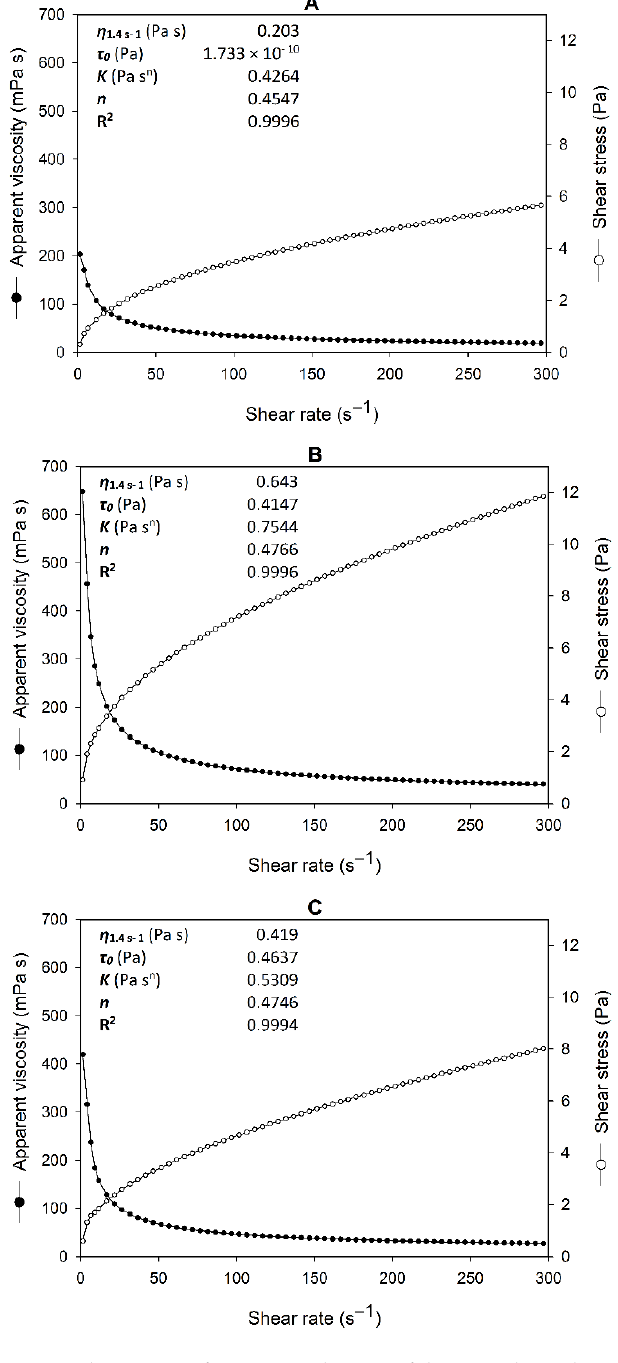
Figure 4. Rheograms of aqueous solutions of the exopolysaccharides produced by Rhizobium viscosum CECT908 grown in synthetic medium (EPS Syn ) ( A ) and alternative low-cost medium (EPS CSLM ) ( B ), when compared with xanthan gum ( C ) (all of them at a concentration of 1 g/L), and rheological parameters obtained according to the Herschel–Bulkley model. The results represent the average of three independent measurements performed at 25 °C.